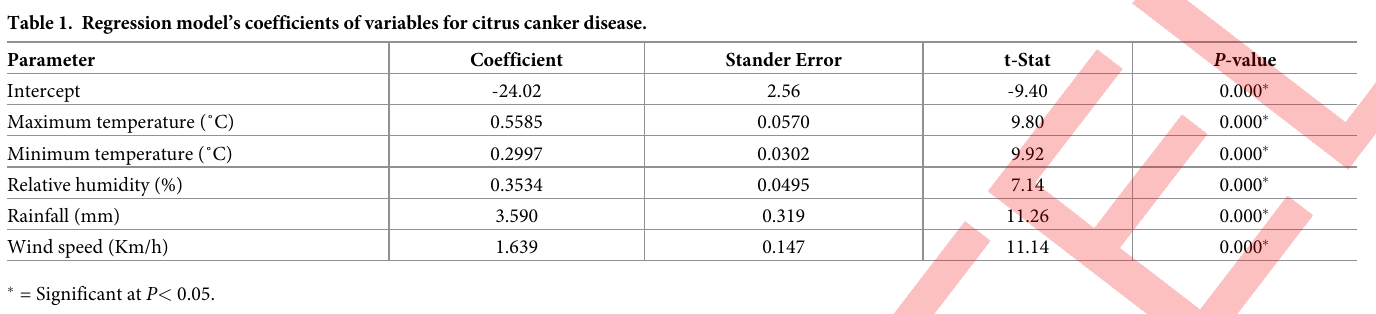
ties during both years. The highest disease incidence (up to 55%) was recorded for Grapefruit